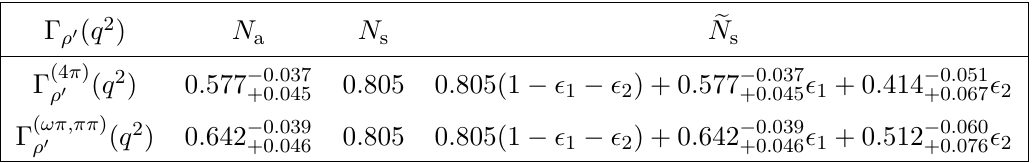
Table 1 . Numerical values of the normalization constants given in equation (3.19) and equa- tion (3.22). The uncertainties refer to the variation Γ ρ 0 = (400 ± 60) MeV, see appendix E. i.e. , to ensure that the constants C and C carry the same meaning in the a 1 / 2 s